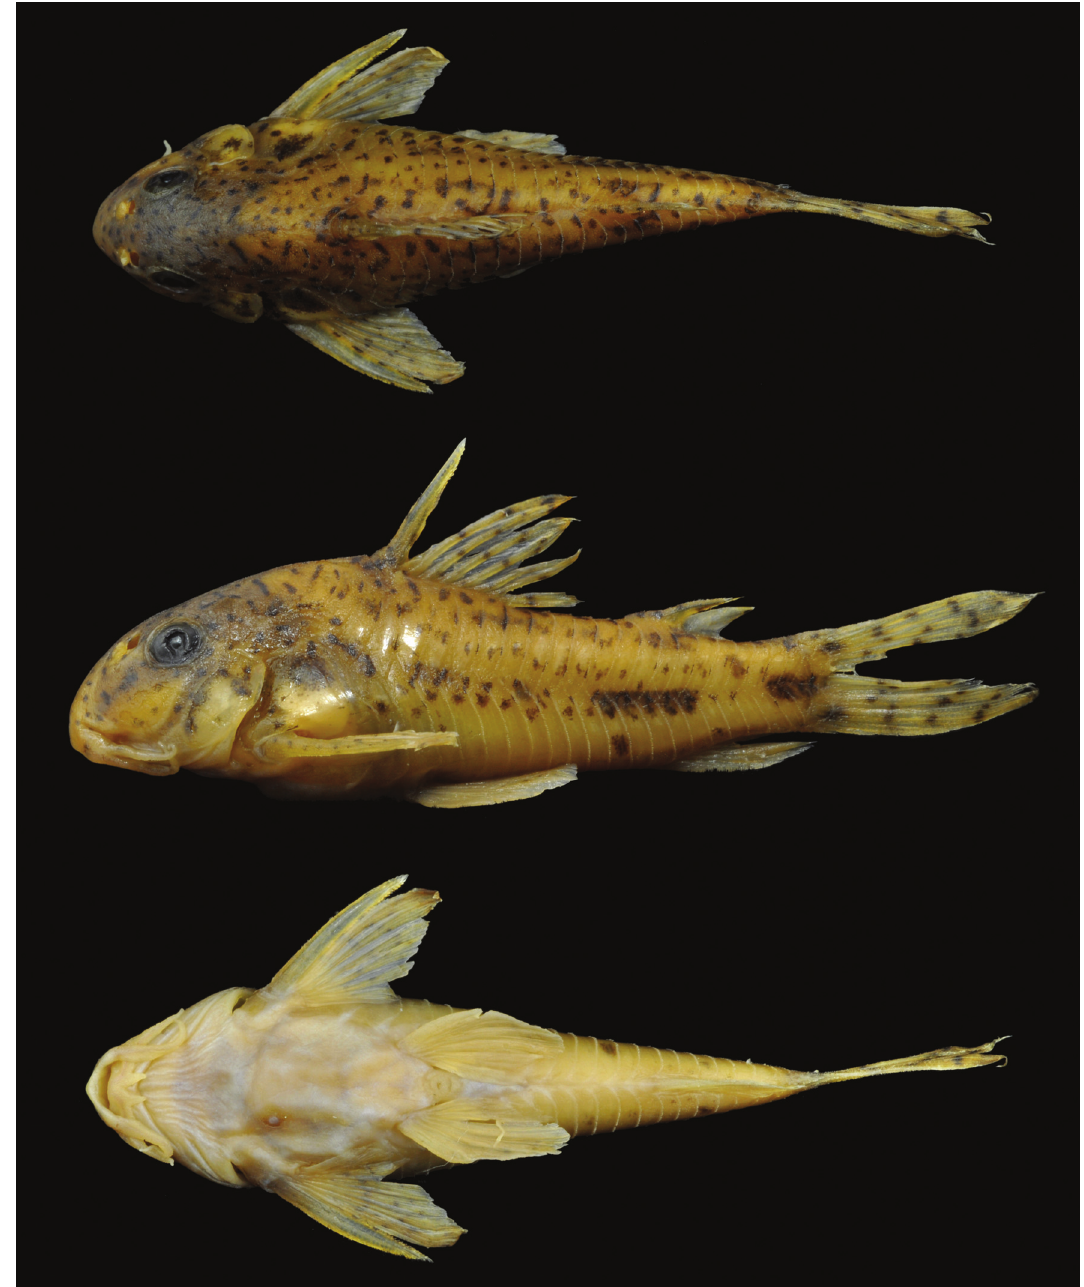
Fig. 1. Corydoras lymnades , holotype, MNRJ 40186, 29.7 mm SL, Brazil, Minas Gerais, Guarda-Mor, rio Guarda-Mor, rio São Francisco basin, 17°46’18”S 47°05’43”W. Dorsal, lateral and ventral